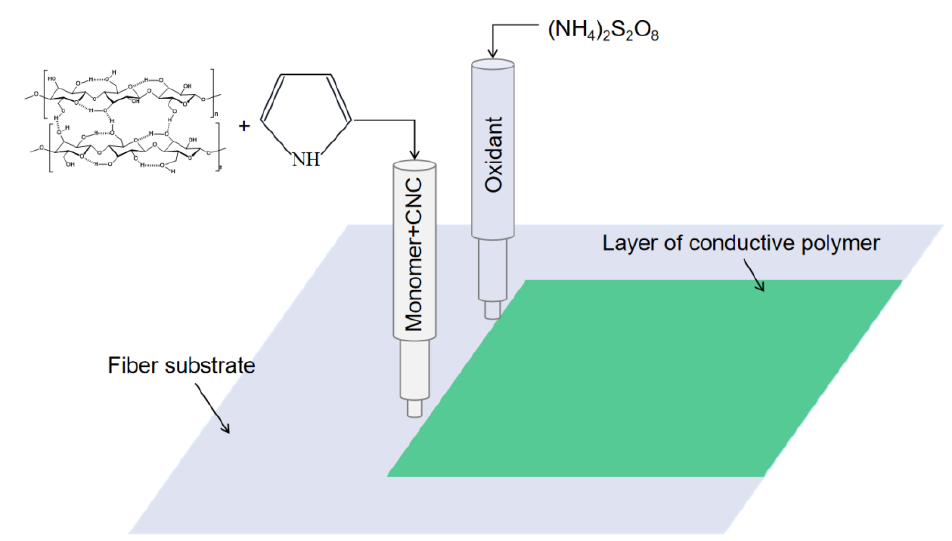
Figure 2. The deposition of PPy/CNCs on fiber substrate by ink-jet printing.